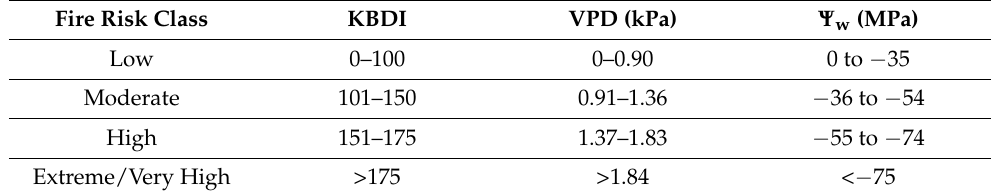
Table 2. Risk classes for the bushfire potential indices. KBDI thresholds are as used in Taufik, Setiawan, & van Lanen [7]. Estimated VPD and Ψ w thresholds (see Section 2.3.2) are also